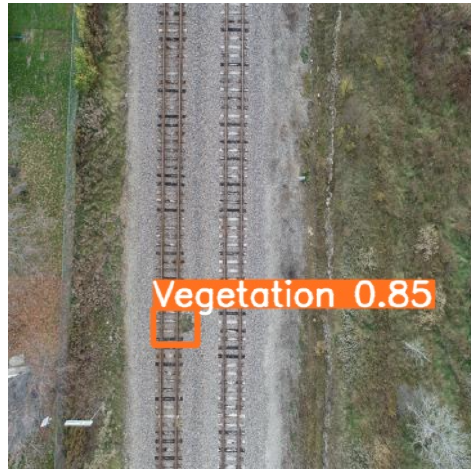
Figure 16. Positive vegetation